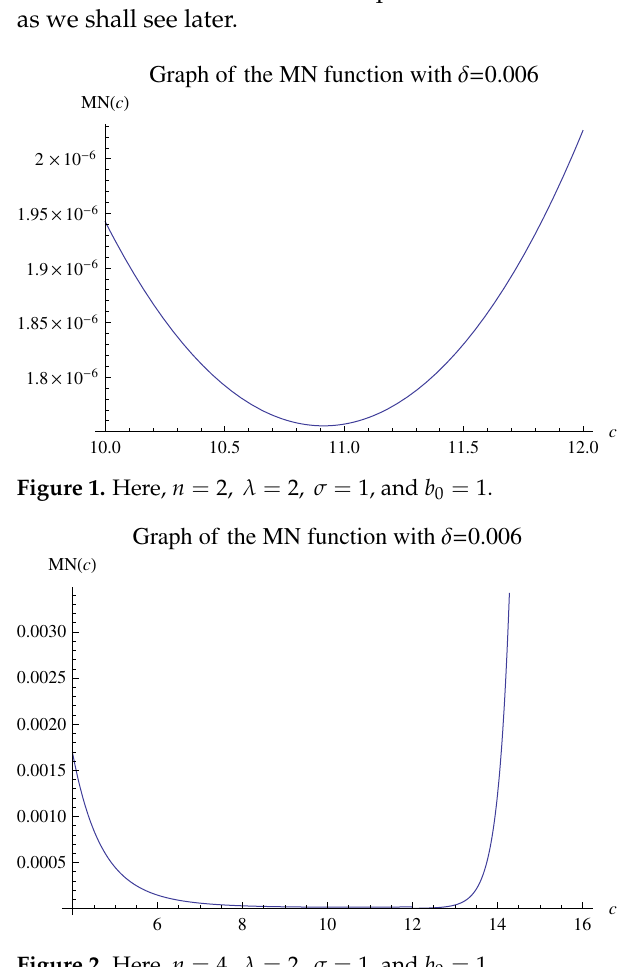
Figure 2. Here, n = 4, λ = 2, σ = 1, and b 0 =